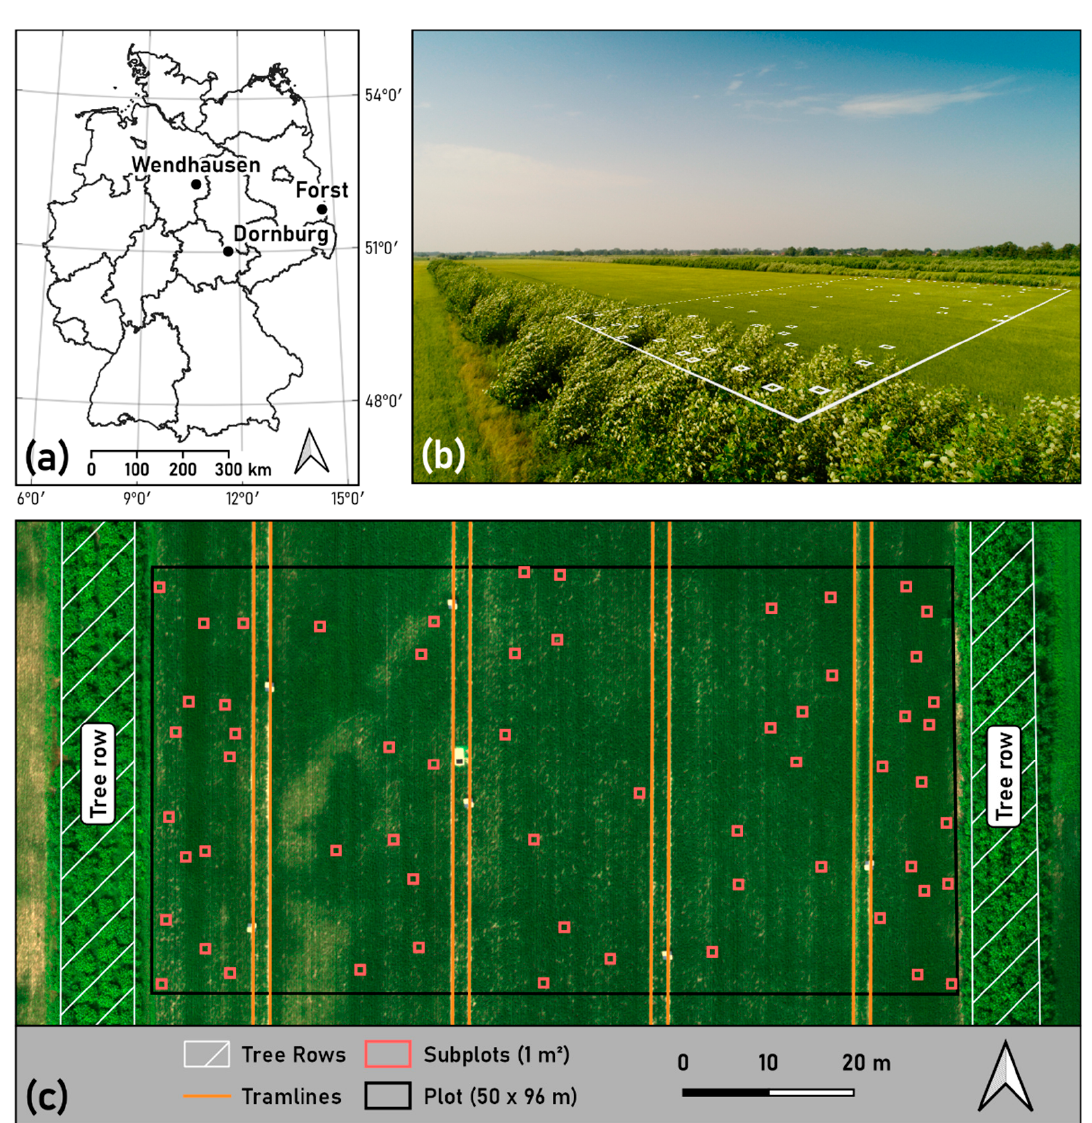
Figure 1. Experimental Sites. ( a ) Location of sampled AFS sites within Germany. ( b ) Photo of AFS site Forst. Footprint of Plot and Subplots are indicated by white lines. ( c ) Map of AFS site Forst.